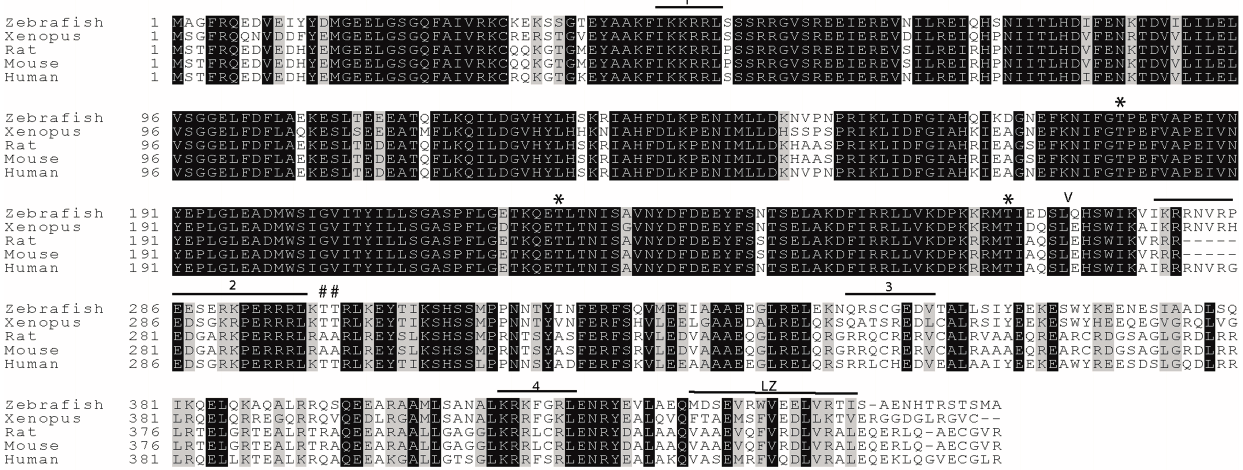
Figure 1. Conservation of regulatory domains of zipper-interacting protein kinase (ZIPK) homologs. A protein sequence alignment of zebrafish ZIPK with human and rat ZIPK; The amino acids marked with a * are phosphorylation sites required for kinase activation in the human ortholog; Amino acids marked with a # are phosphorylation sites that modulate nucleo-cytoplasmic shuttling in the human ortholog; Numbered regions indicate the four conserved nuclear localization sequences; LZ indicates the leucine zipper; amino acids N -terminal to the V are the kinase domain; accession numbers are available in the experimental